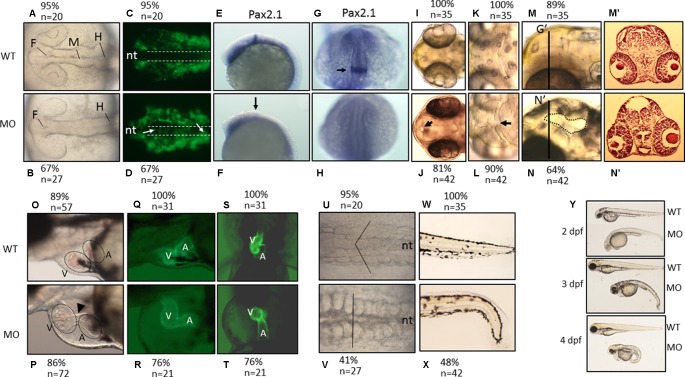
The morphological characteristics of zPnpo morphants. Zebrafish embryos of wild-type and transgenic lines injected with zPnpo MO at one- to two-cell stages were grown in embryo water and recorded for embryonic organogenesis and development. Tg(sox10:eGFP) embryos with/without MO injection were imaged at 18 hpf under dissecting light and fluorescent microscopes (A–D) and also subjected to WISH analysis with riboprobes pax2.1
(E–H). Migratory neural crest cells (green fluorescent signals pointed by white arrows) were absent in the closing neural tube (dashed line) of wild-type larvae but remained in that of morphants. Lack or significantly reduced signal for pax2.1 (arrows) were also observed in zPnpo morphants. Both wild-type and zPnpo morphants at 2 dpf were imaged for brain region (I–N). A crater-like opening was observed in diencephalic ventricle (arrows) and hindbrain (circled area) of zPnpo morphants. H&E-stained cryosections prepared from the head region [indicated by vertical lines in (N)] of 2-dpf morphants revealed a cavity (*), which was not observed in wild-type larvae (M’ and N’). Tg(cmlc2:eGFP) embryos with/without MO injection were imaged (O–R) and video-recorded (S and T, the representative still frames from
Suppl. 3–10
) under a fluorescent microscope for heart development at 3 dpf. A tubing heart with incorrectly positioned ventricle and atrium were apparent in zPnpo morphants. The somite formation (U and V) and the development of trunk and tail (W and X) were recorded at 18 hpf and 3 dpf, respectively. The somites with chevron shape (solid line in U) can be seen in wild-type embryo. The full view of larvae at the indicated stages was imaged from the lateral view to show the overall morphology and size, which also revealed apparent body curvature for zPnpo morphants (Y). For the images to be taken, embryos/larvae of the indicated stages were removed from the embryo water and placed individually on a drop of methylcellulose for photographing. All images were taken with anterior to the left for lateral view except for brain (A–D, E–L) and somites (U–V) (dorsal) and video recording (S and T) (ventral). WT, wild-type; MO, zPnpo morphants; F, forebrain ventricle; M, midbrain ventricle; H, hindbrain ventricle; nt, neural tube; V, ventricle; A, atrium; WISH, whole-mount in situ hybridization; H&E, hematoxylin and eosin.